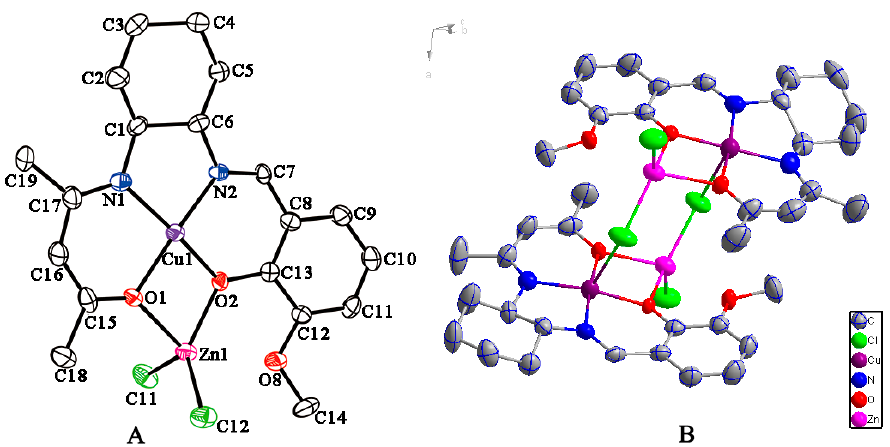
Figure 5. ( A ) X-ray crystal structure of the Cu-Zn complex (thermal ellipsoids are set at the 30% probability level); ( B ) ball-and-stick views of the dimer. All hydrogen atoms and solvent molecules were omitted for clarity.